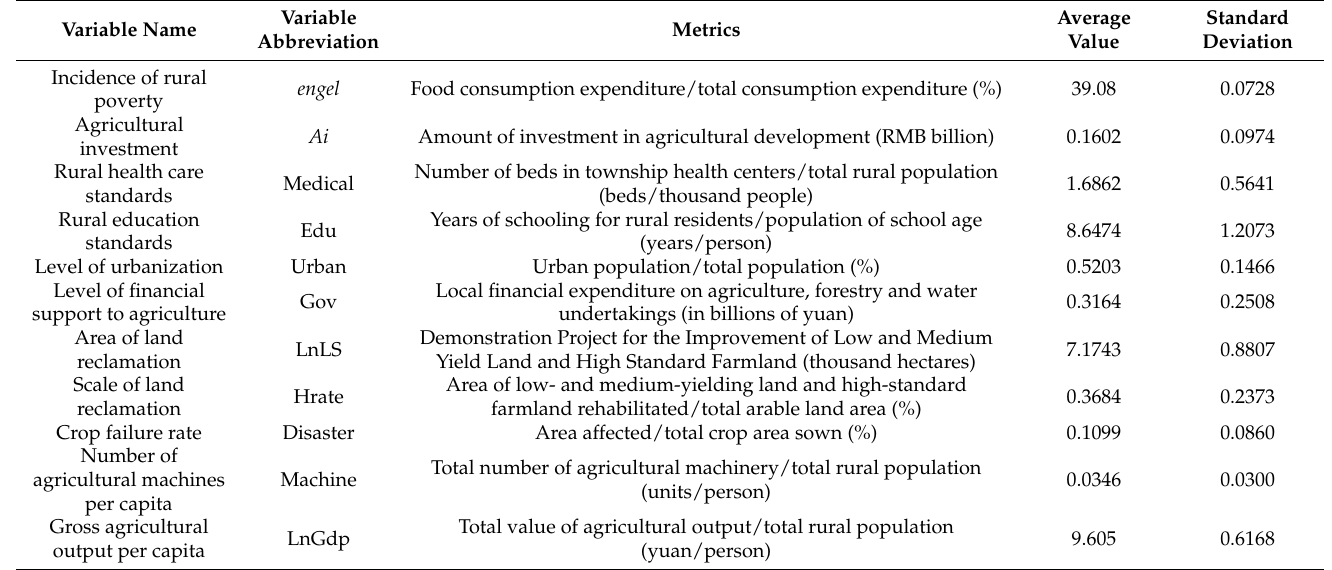
Table 1. Descriptive